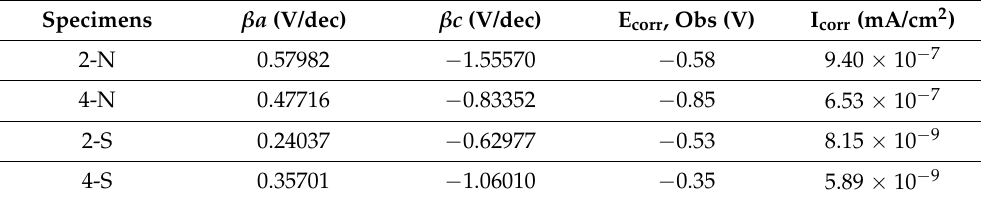
Figure 14. Polarization curves of A535 specimens with different etching time and sealants were tested in a 5 wt.% NaCl solution. Table 4. Corrosion parameters of anodic coefficient ( β a ), cathodic coefficient ( β c ), potential (E corr ), and corrosion current density (I corr ) of the tested samples obtained from a Tafel